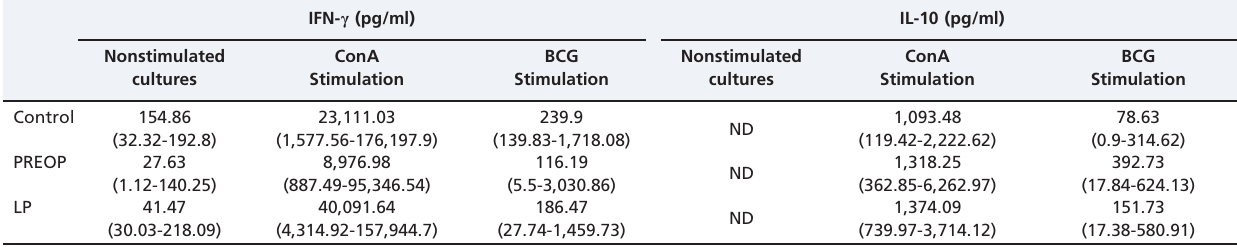
Table 2 - Control, preoperative (PREOP), and late postoperative (LP) IL-10 and IFN- c levels in non-stimulated cell cultures and in cultures stimulated with ConA and BCG.